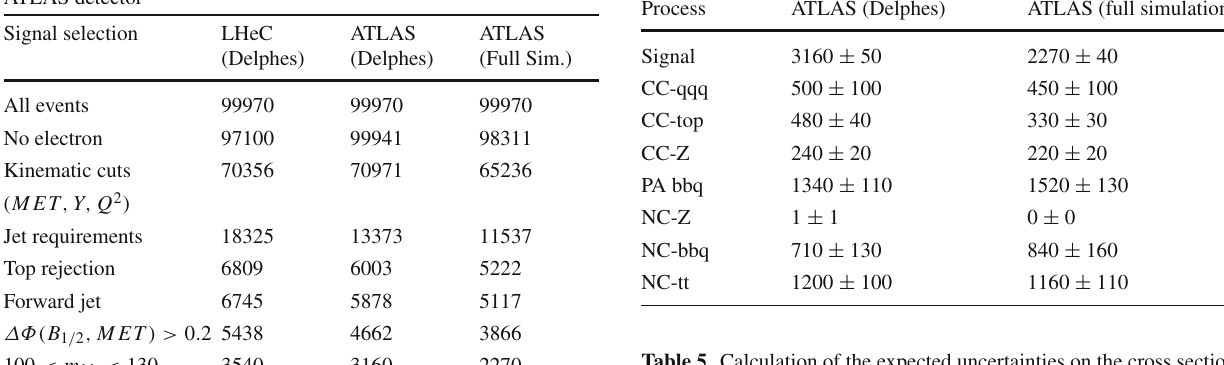
Table3 Cutflowforthesignalsamples pe → ν H ( → bb ) j normalised (cid:4) Ldt = 1 ab − 1 for different detector simulations using Delphes to for the LHeC detector and ATLAS, as well as a full simulation of the ATLAS detector